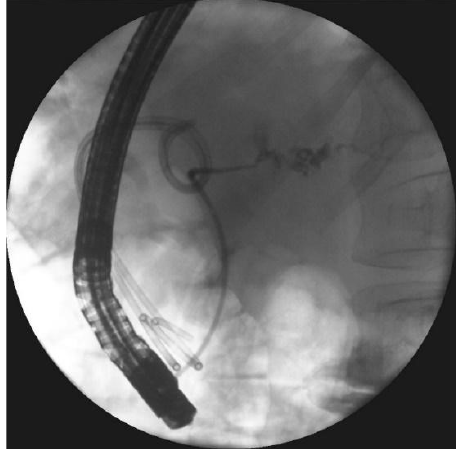
Figure 9. ERP was performed during transmural drainage of the WOPN. Complete disruption of the pancreatic duct within the tail can be seen, which causes contrast dye to spill outside the duct. ERP, endoscopic retrograde pancreatography; WOPN, walled-off pancreatic necrosis.